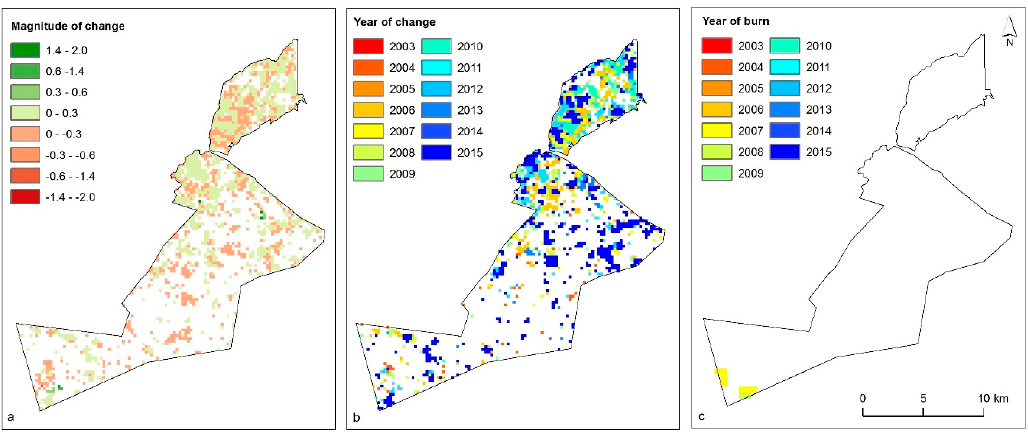
Figure 6. Change maps for Shimba Hills National Reserve from 2003–2015 showing: ( a ) The magnitude of change in the MODIS EVI derived using BFAST; ( b ) The year the breakpoint was detected by BFAST; ( c ) Areas of fire detected by the MODIS MCD451A product.